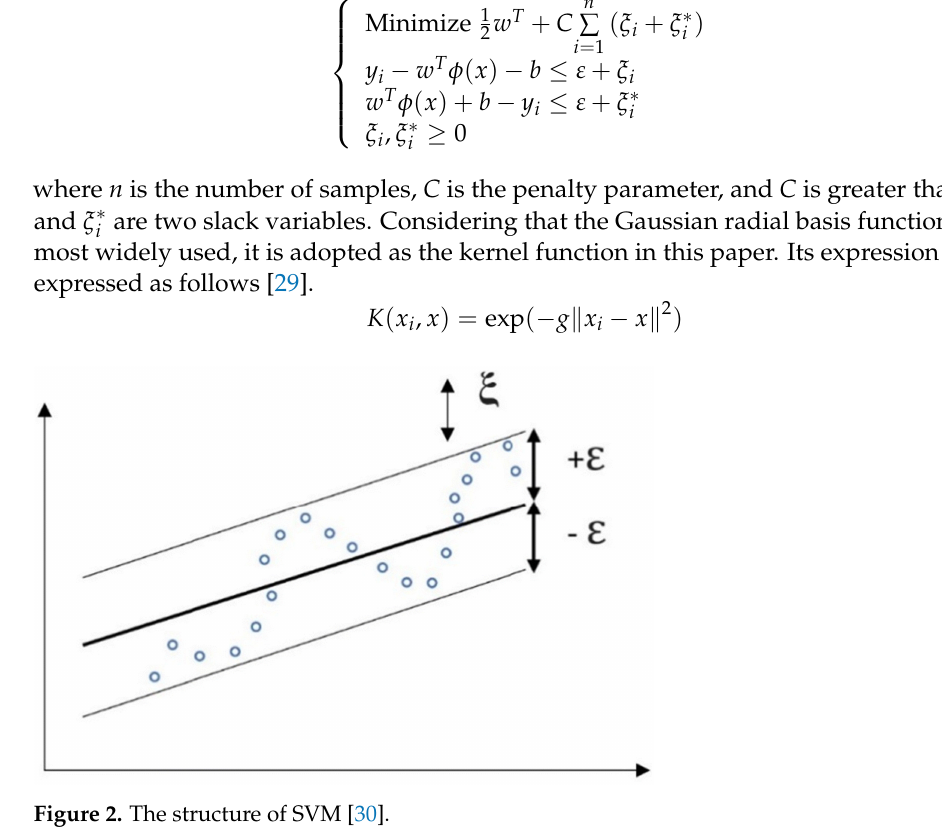
Figure 2. The structure of SVM